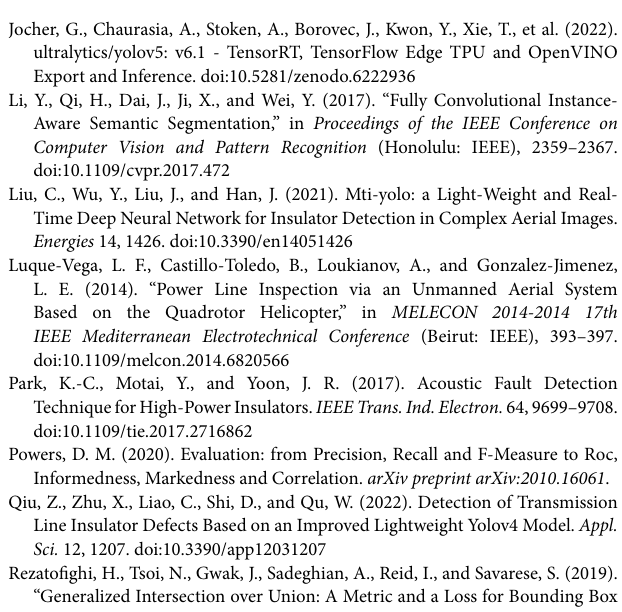
right objects, while YOLOv5 still suffers from low